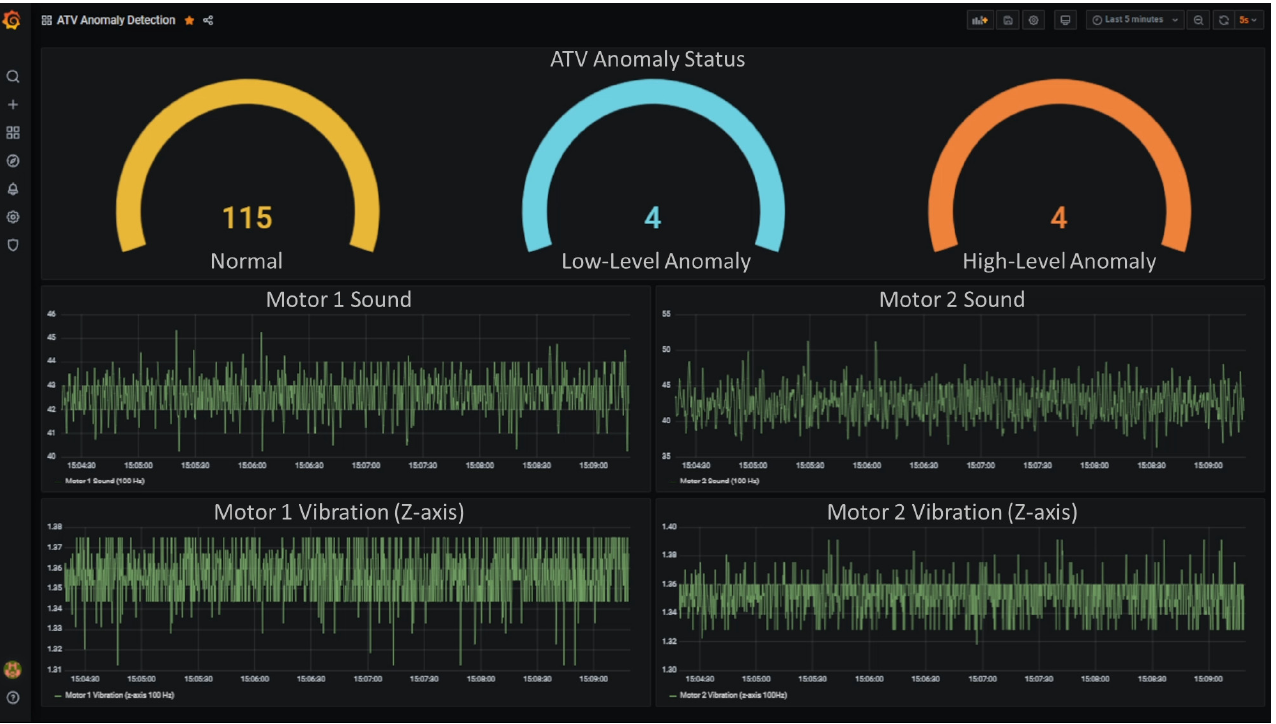
Figure 6. Grafana dashboards for real-time condition monitoring.